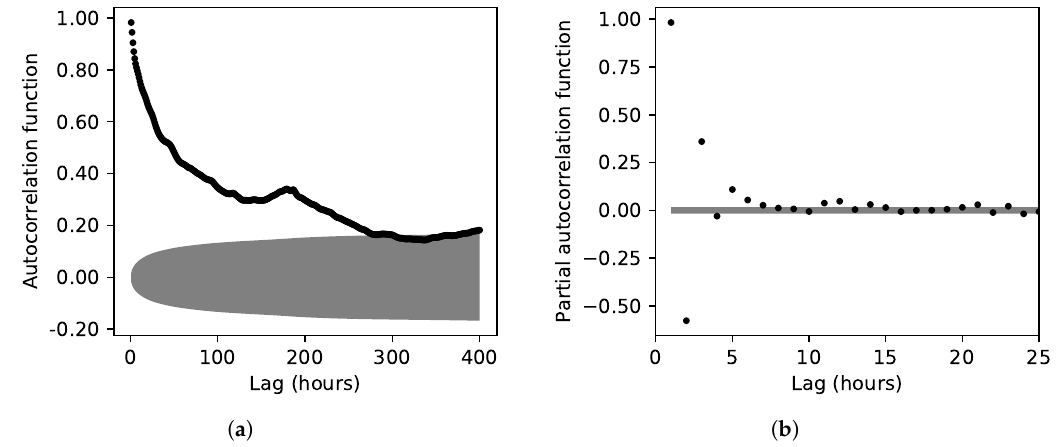
Figure 4. ( a ) Autocorrelation function (ACF) and ( b ) Partial autocorrelation function (PACF) of the Matadero-Sayausí discharge series. Gray hatch indicates the 95% confidence band.